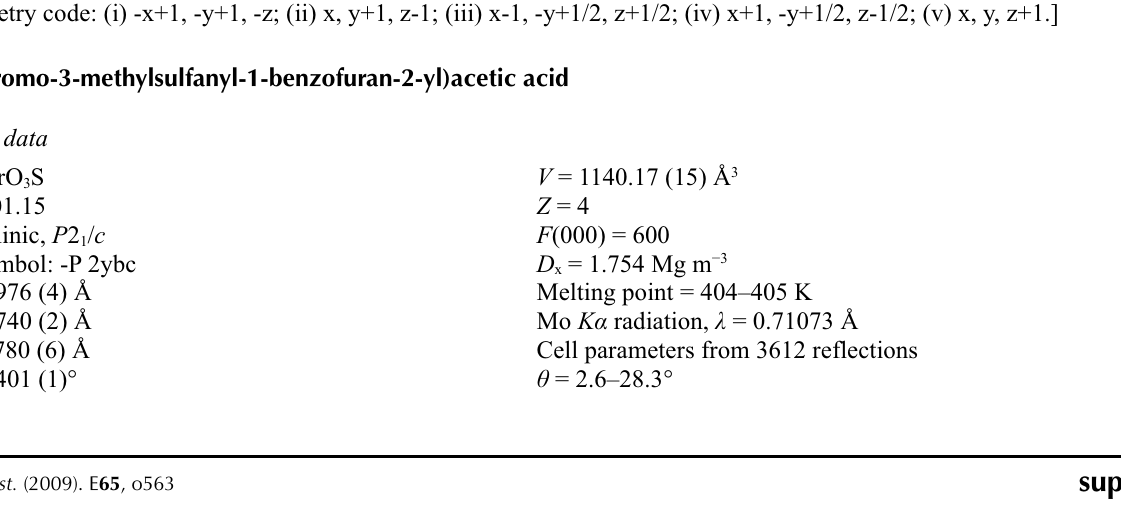
sup-3 Acta Cryst. (2009). E 65 , o563